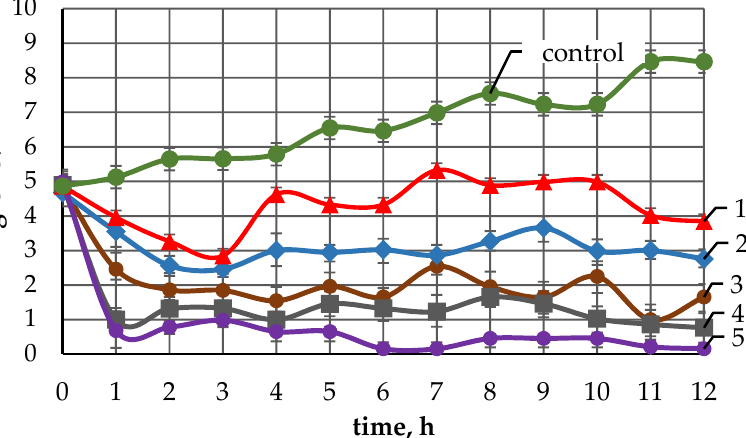
Figure 3. E. coli growth inhibition in presence of: (1) Sample 1-TiO 2 /Ag 14.7 at.% /Cu 13.0 at.% ; (2) Sample 2-TiO 2 /Ag 4.0 at.% /Cu 17.9 at.% ; (3) Sample 3-TiO 2 /Ag 14.3 at.% /Cu 21.3 at.% ; (4) Sample 4-TiO 2 /Ag 18.6 at.% /Cu 22.4 at.% ; (5) Sample 5-TiO 2 /Ag 23.1 at.% /Cu 21.6 at.% ; or in absence of sample—control.